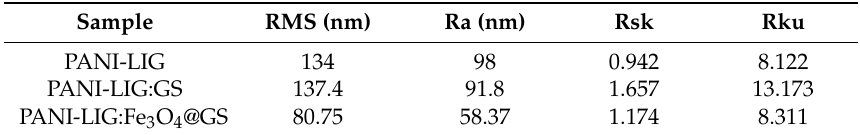
Table 1. The roughness parameters values for polyaniline grafted lignin (PANI–LIG)-based